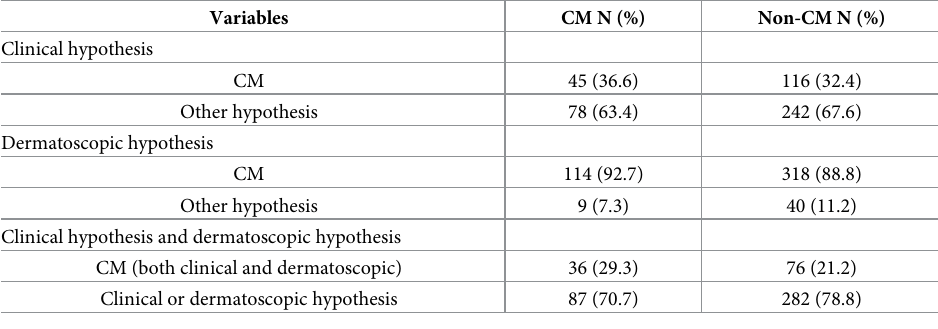
Table 3. Comparison between clinical and dermatological hypotheses of cutaneous melanoma of 481 analyzed melanocytic lesions � 6mm in